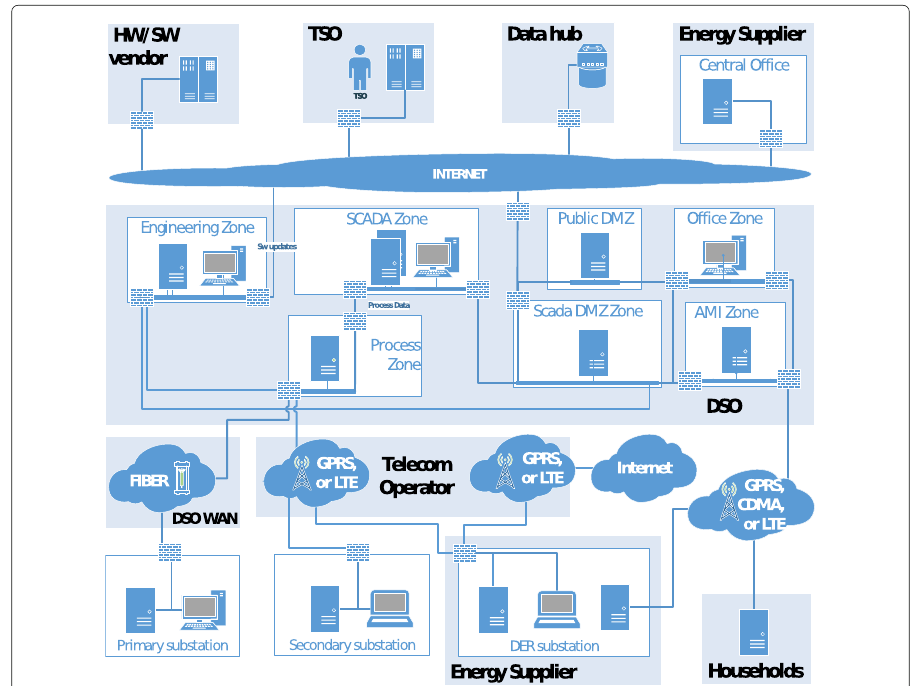
Fig. 1 Diagram of a typical smart grid